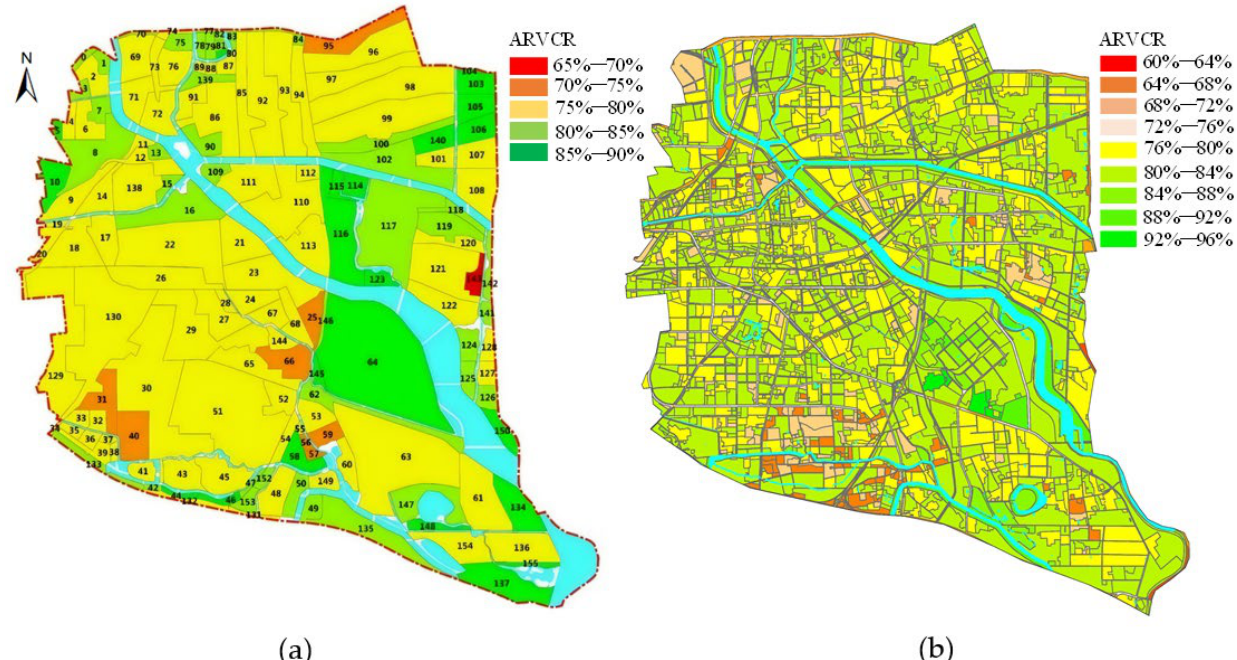
Figure 6. Comparison of the ARVCRs based on overall planning and the assignment via statistical methods. ( a ) ARVCR of overall planning; ( b ) ARVCR assigned by statistical model.